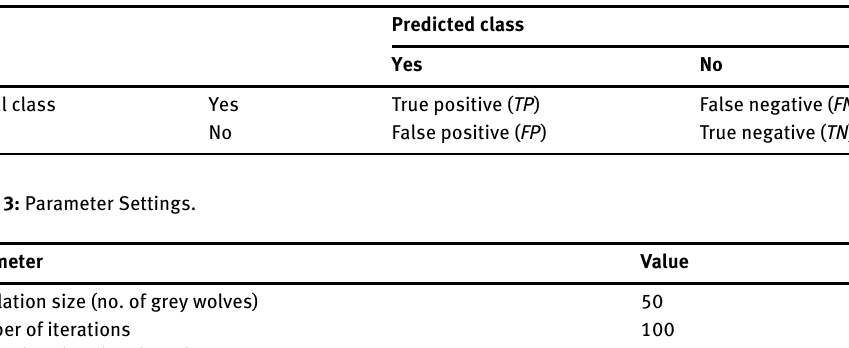
Table 2: Confusion Matrix for a Classifier.